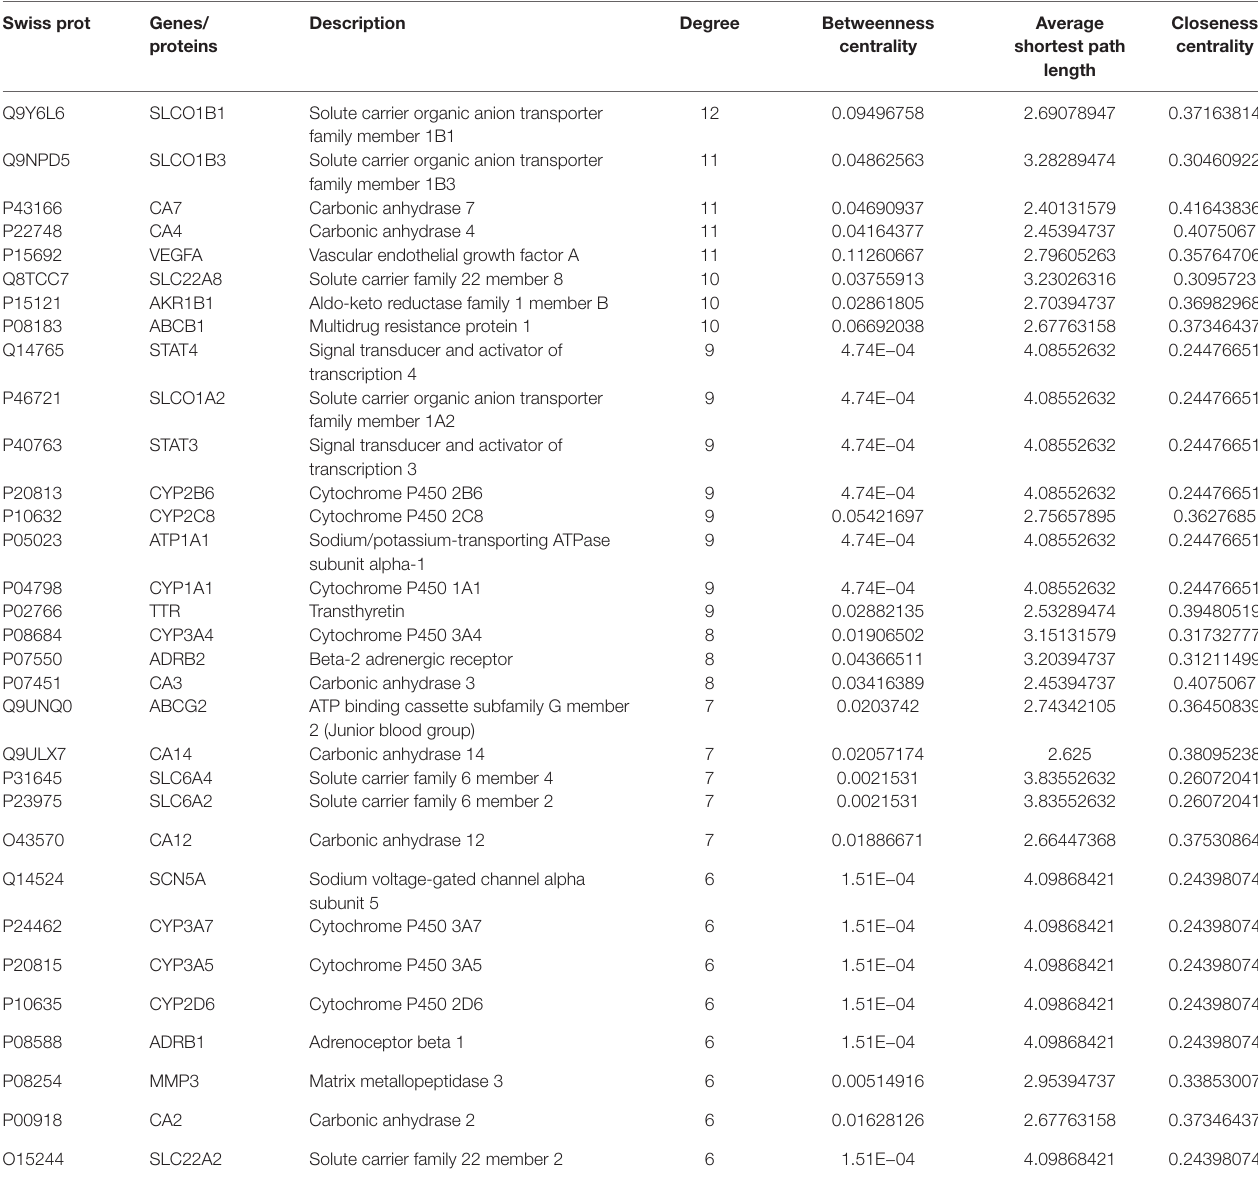
TABLE 2 | The topological parameters of 32 major targets. Swiss prot Genes/